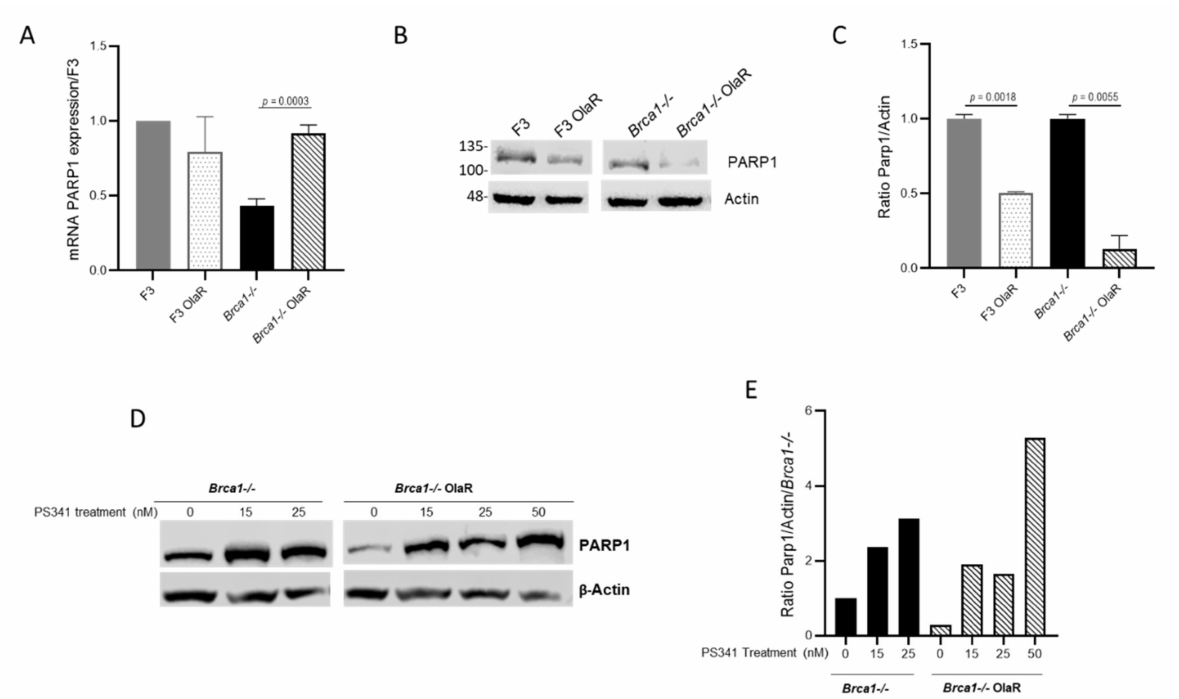
Figure 3. PARP1 expression in F3, F3 OlaR, Brca1-/- and Brca1-/- OlaR cells. ( A ) PARP1 mRNA expression measured by RT-PCR and normalized by actin mRNA in F3 (filled grey column), F3 OlaR (patterned grey column), Brca1-/- (filled black column) and Brca1-/- OlaR cells (patterned black column). Values are the mean ± SD of three independent experiments, carried out in triplicate and are expressed as fold-change over the corresponding sensitive cells. ( B ) PARP1 protein in F3, F3 OlaR, Brca1-/- and Brca1-/- OlaR cells detected by western blot analysis. Actin was included as internal loading control. ( C ) Densitometric analysis of the western blot results expressed as the ratio of PARP1 to actin level. ( D ) PARP1 western blot analysis in cells treated or not with different doses of the proteasome inhibitor PS341 for 8 h. ( E ). Densitometric analysis of the PARP1 western blot results. Data are expressed as the ratio of PARP1 to actin level over the Brca1-/- PARP1 to actin ratio. For statistical analyses unpaired t -test was